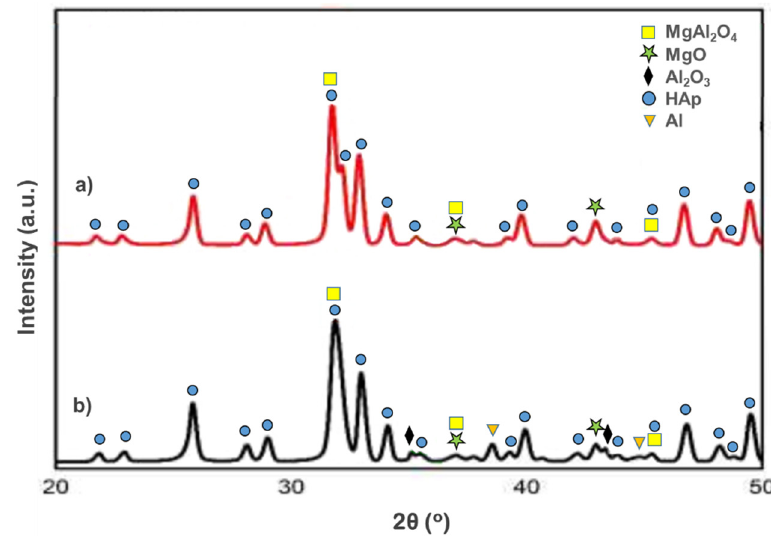
Figure 5. XRD of the hydroxyapatite composite made using Al particle size-fraction of < 90 µ m and compaction pressure of ( a ) 200 and ( b ) 100 MPa.